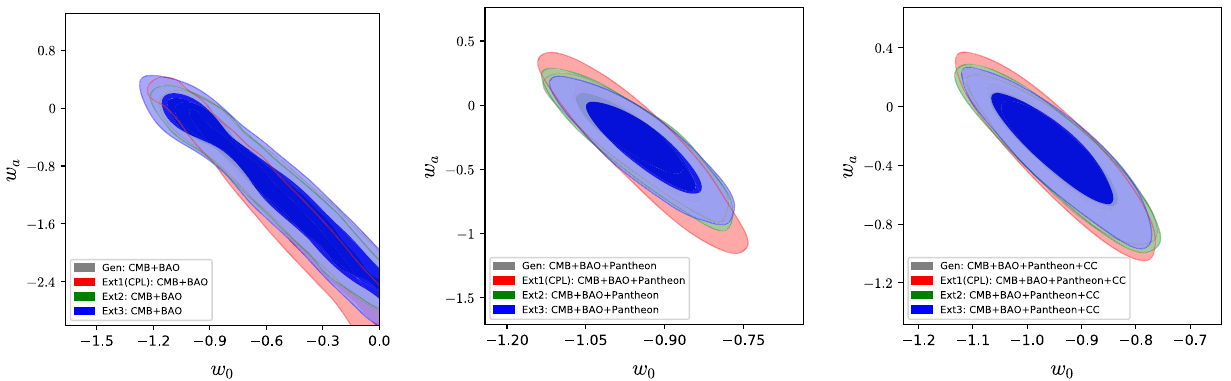
Fig. 10 We show the (w 0 ,w a ) plane for the present dynamical dark energy parametrizations using different observational datasets. The left graph for the dataset CMB+BAO, the middle graph for the dataset CMB+BAO+Pantheon and the right graph stands for the observational dataset CMB+BAO+Pantheon+CC Table 6 For a clear understanding and comparison of the dark energy key parameters ( w 0 , w a ) extracted from all the parametrizations, we show their estimations at 68% CL. Here, CB = CMB+BAO, CBP = CMB+BAO+Pantheon, CBPC = CMB+BAO+Pantheon+CC Datasets Parameters Gen Ext1 (CPL) Ext2